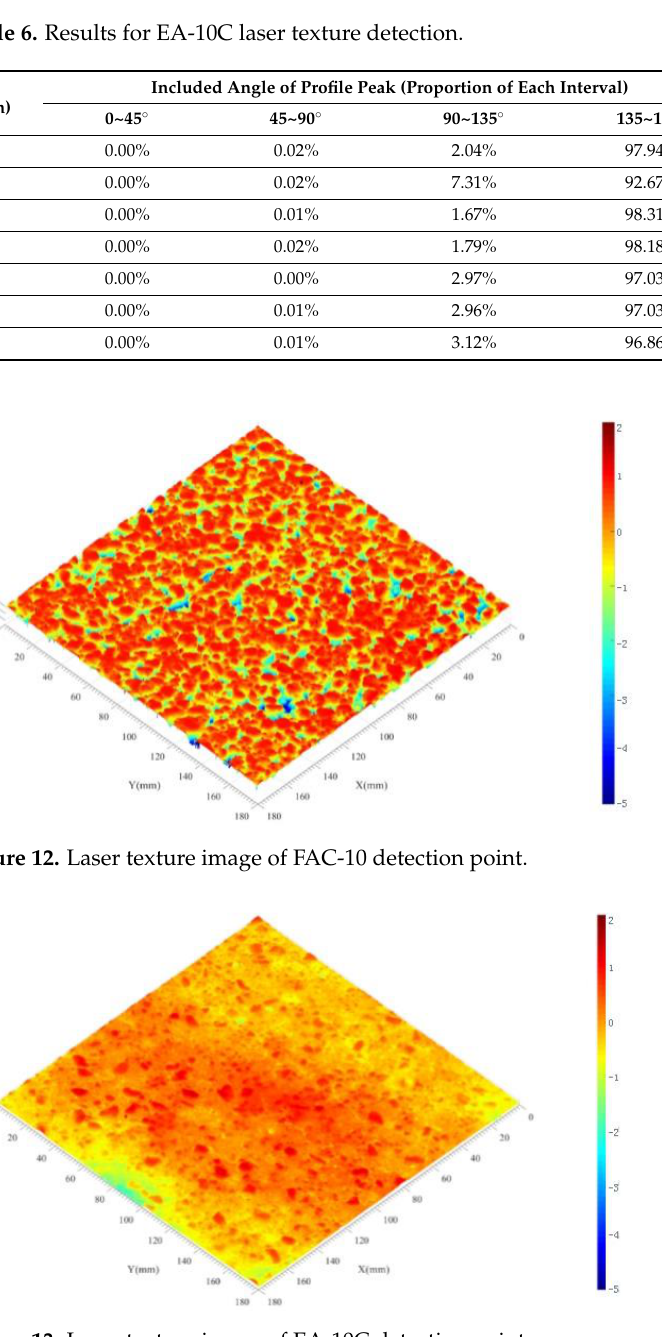
Figure 13. Laser texture image of EA-10C detection point.